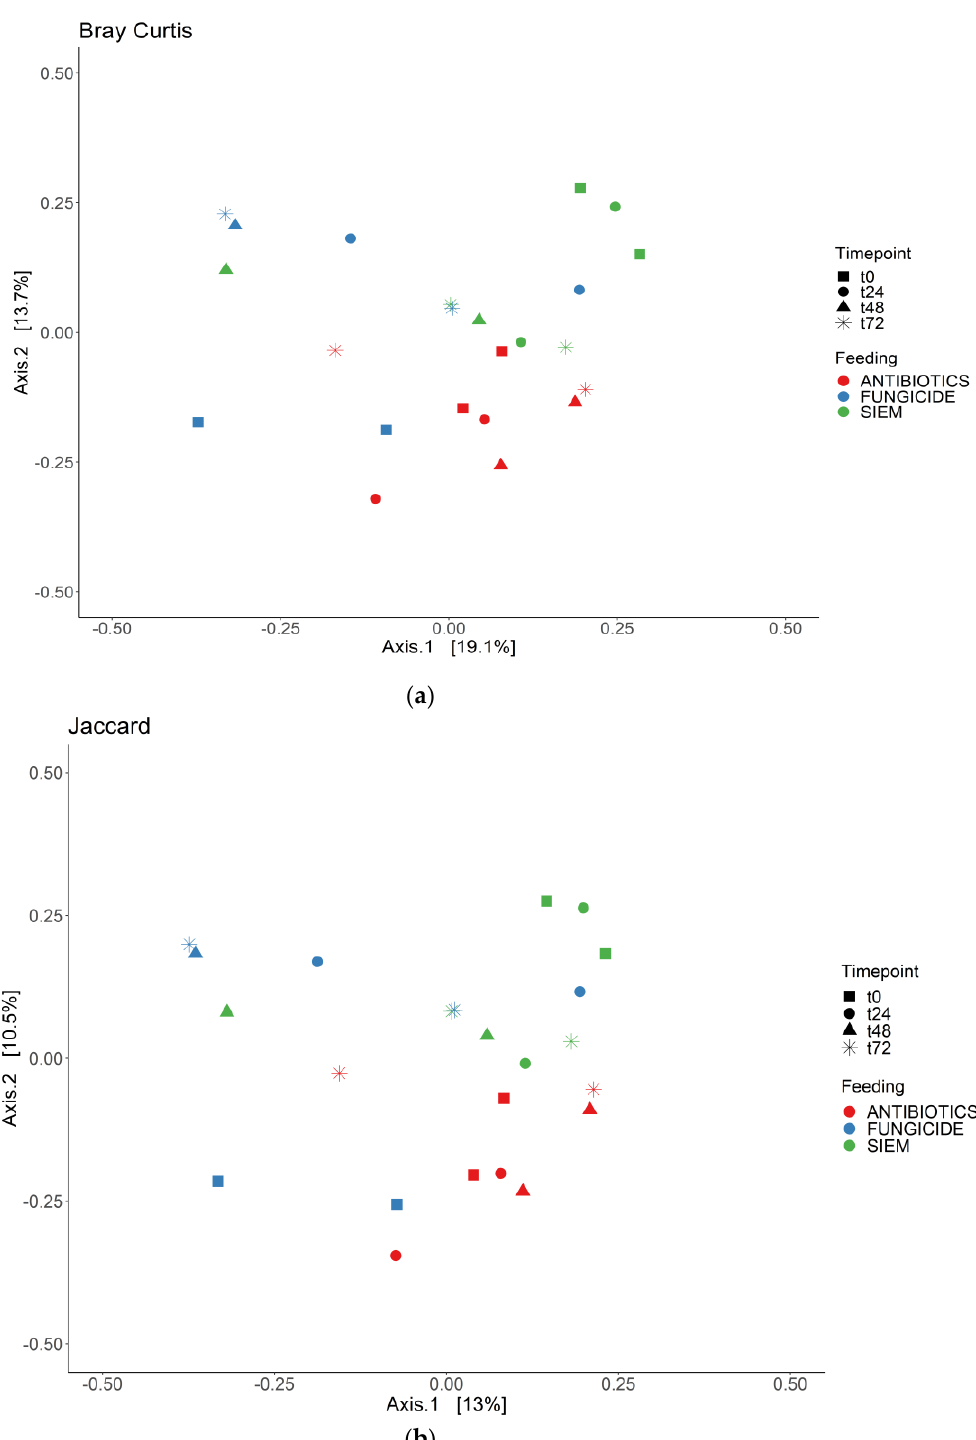
Figure 3. PCoA for bacteria; ( a ) Bray Curtis dissimilarity; and ( b ) Jaccard.